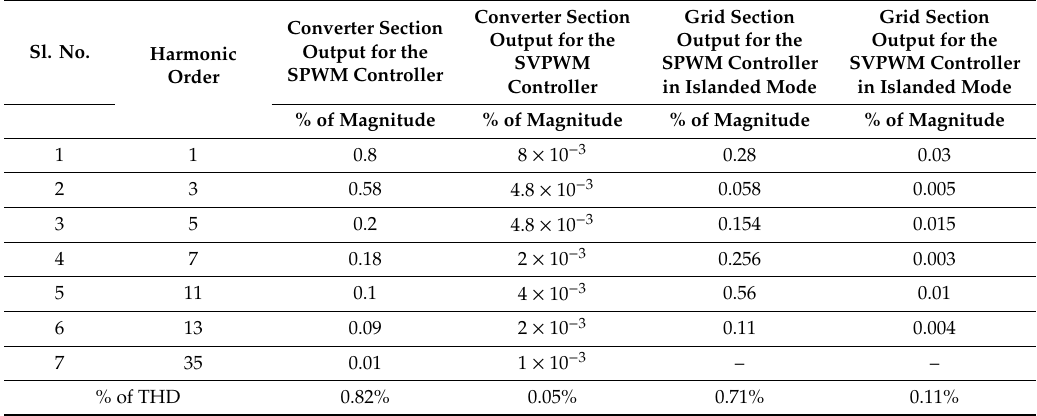
Table 3. Comparison of the THD in the converter section and the grid section with the sinusoidal PWM (SPWM) and SVPWM controllers.